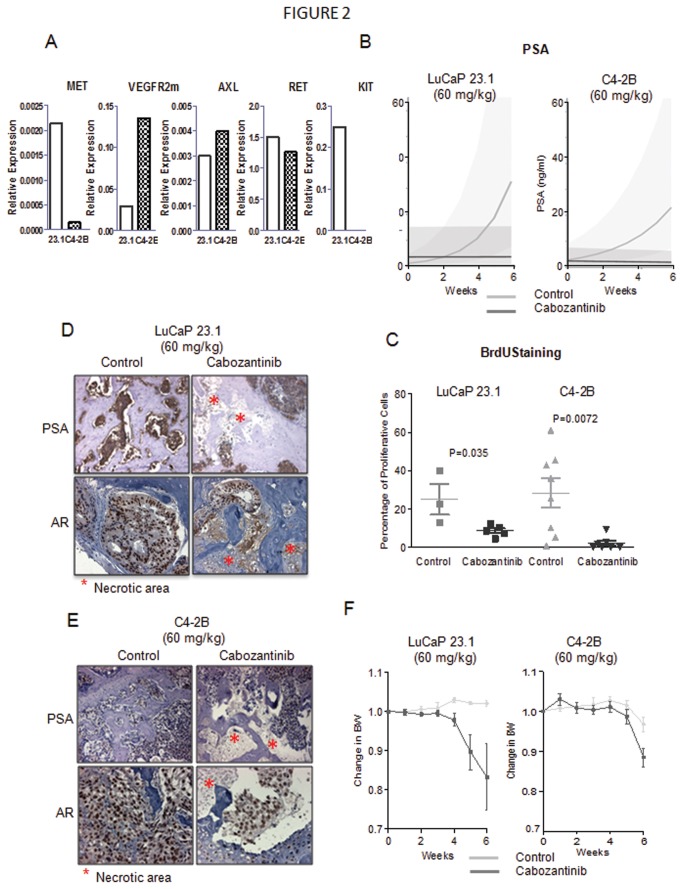
Cabozantinib (60 mg/kg) inhibits tumor growth in androgen-sensitive and castration-resistant PCa in bone.A. Levels of cabozantinib receptors in LuCaP 23.1 and C4-2B subcutaneous tumors. qPCR was used on RNA isolated from subcutaneous tumors to determine expression levels of MET, VEGFR2m, AXL, RET and KIT. To calibrate the signal we used four-fold dilution of LNCaP cDNA (RET), PC-3 cDNA (MET, AXL, KIT) and LuCaP 23.1 (VEGFR2m). Selection of the calibrator cDNA was based on signal for each specific message. Signal was normalized to housekeeping gene RPL13a. Our results indicate that LuCaP 23.1 tumors express all of the cabozantinib targets and C4-2B tumors express VEGFR2m, AXL and RET, low levels of MET, and no KIT. In these qPCR experiments, we measured relative levels of the target transcripts and not their actual numbers, therefore we cannot compare expression levels of the different targets to each other, and comment whether RET, which gave the higher signal, might be expressed at higher copy number vs MET, and therefore is more important in these models. B. Linear models of PSA growth show that cabozantinib decreases PSA levels in both androgen-sensitive LuCaP 23.1 and castration-resistant C4-2B models. C. BrdU staining of tibiae shows that cabozantinib decreases proliferation of androgen-sensitive and castration-resistant tumor cells in bone, 2-sided t-test was used to determine the significance of the differences. D & E. AR and PSA immunoreactivity is present in control tumors. Cabozantinib treatment resulted in decreases in AR and PSA immunoreactivity in both models (LuCaP 23.1 (D) and C4-2B (E)). C4-2B cells express lower levels of PSA in comparison to LuCaP 23.1, and the staining is weaker in these tumor. Furthermore, large necrotic areas of tumor are present in the treated tibiae (marked by red asterics). F. 60 mg/kg cabozantinib is well tolerated up to 4 weeks in androgen-sensitive LuCaP 23.1 animals. After this period significant BW decreases vs. control were detected (up to 17%), but because of variation and number of animals, these decreases did not reach significance. 60 mg/kg cabozantinib is well tolerated up to 5 weeks in the castration-resistant C4-2B model, with a 12% significant decrease at week 6. Significance was determined by comparing enrollment BW to BW at each week using 2-sided t-test. Mean ± SEM of the groups is plotted.